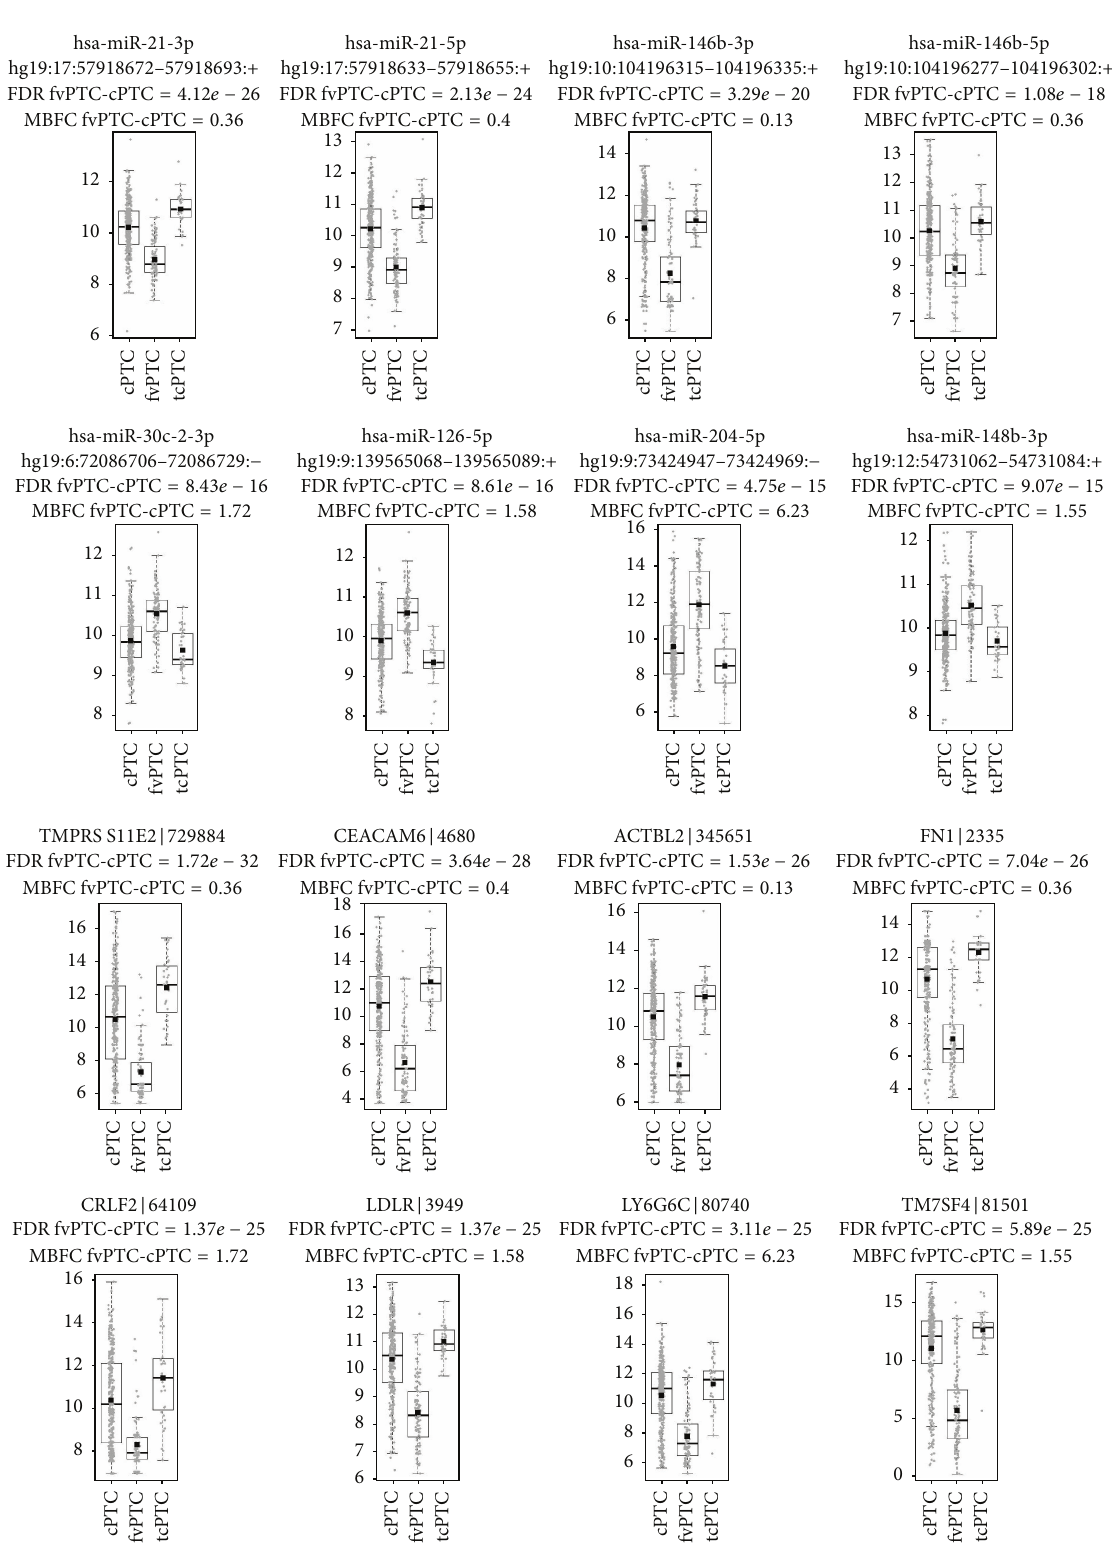
Figure 2: miRNAs and genes with the most differentially changed expression in classic PTC versus follicular variant PTC. Distributions of cPTC and fvPTC expression data overlap significantly; on the other hand, fvPTC and tcPTC distributions are relatively diverse. Top 8 miRNAs and genes were selected according to rules presented in Section 2, Statistical Testing and Annotation. miRNA data were annotated with hsa-miR number and hg19 isoform loci, whereas gene expression data were annotated with gene symbol and Gene